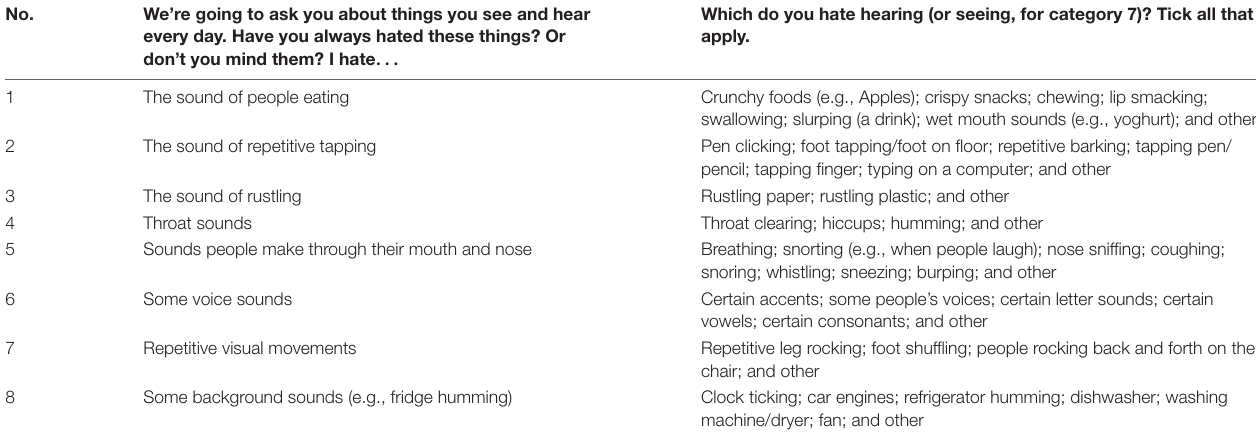
TABLE 1 | Triggers for misophonia, and their superordinate category.